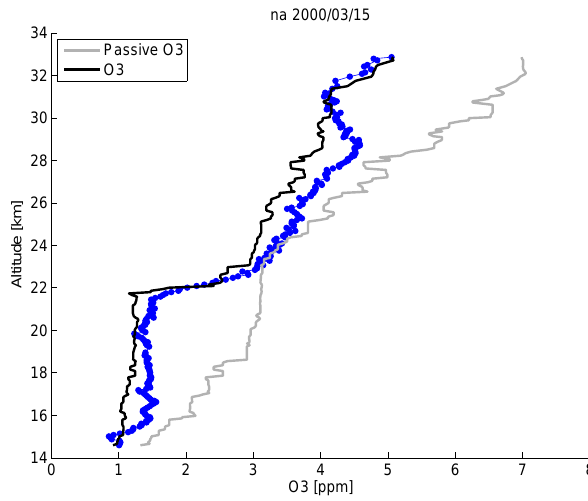
Fig. 4. Ozone sonde measurement from Ny- ˚ Alesund, Spitzbergen on 15 March 2000 (blue dots) compared to modeled ozone values (black line). The grey line shows the passive ozone tracer to indicate the amount of ozone loss.